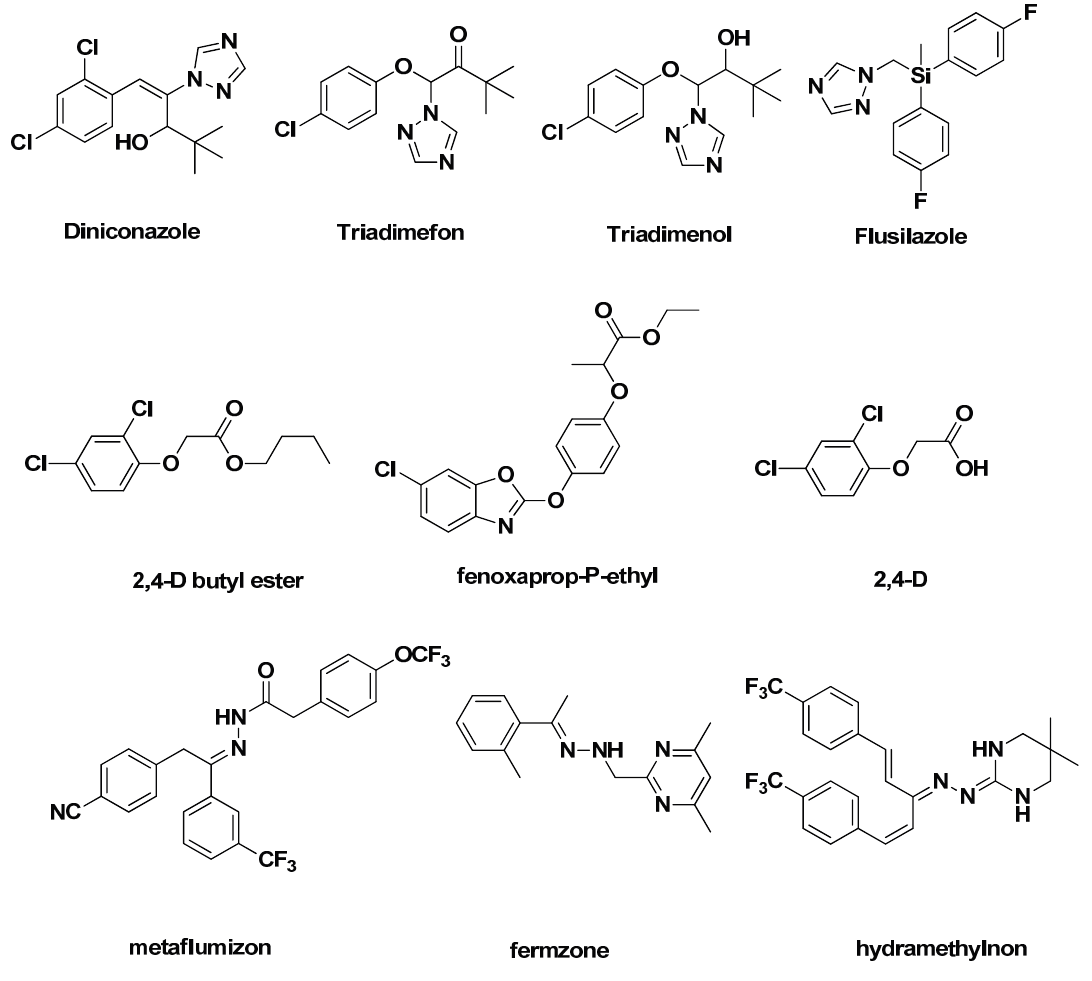
Figure 1. Some representative commercial drugs or